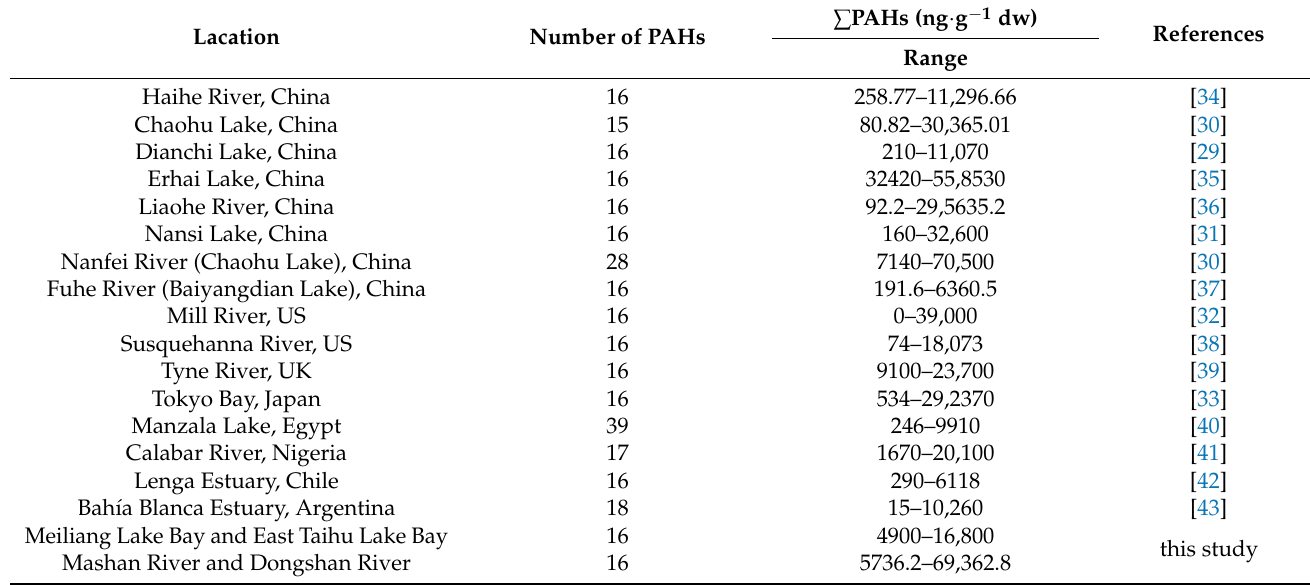
Table 1. Comparison of polycyclic aromatic hydrocarbons (PAHs) concentrations (ng · g − 1 dry weight (dw)) in surface sediments from different rivers, estuaries, and lakes in the